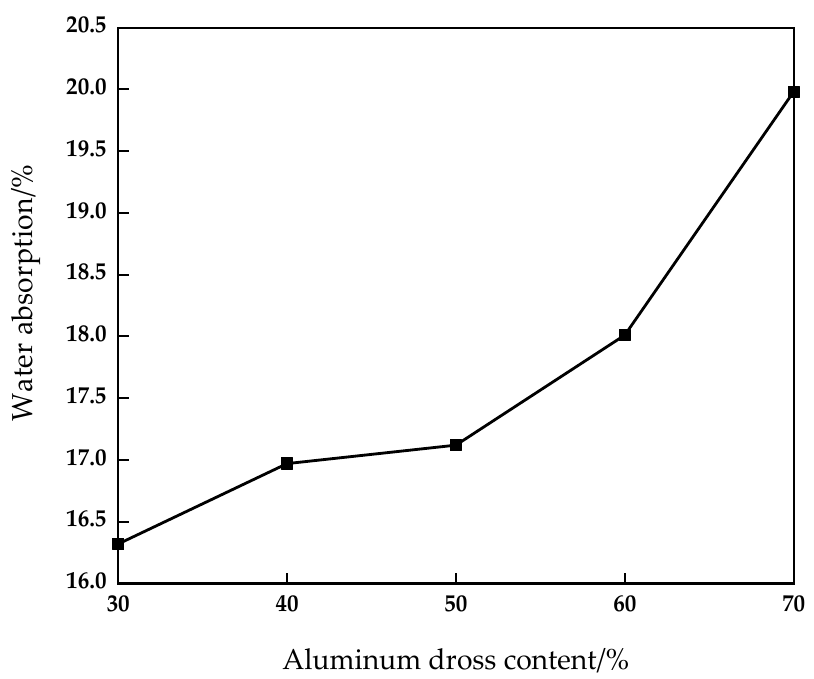
Figure 6. Effect of aluminum dross content on water absorption of fired brick.